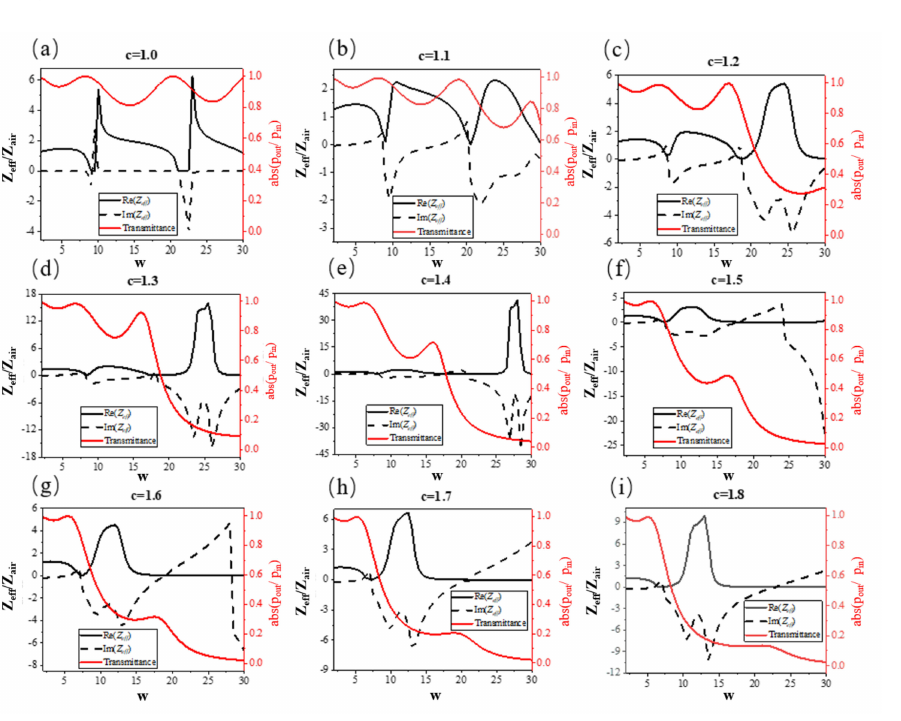
Figure 3. The amplitude of transmitted waves (red lines) and the effective acoustic impedance of waveguide unit (black lines) with different values of ‘ c ’. ( a ) c = 1.0; ( b ) c = 1.1; ( c ) c = 1.2; ( d ) c = 1.3; ( e ) c = 1.4; ( f ) c = 1.5; ( g ) c = 1.6; ( h ) c = 1.7; ( i ) c = 1.8. w and c eff are scale factor and equivalent velocity,